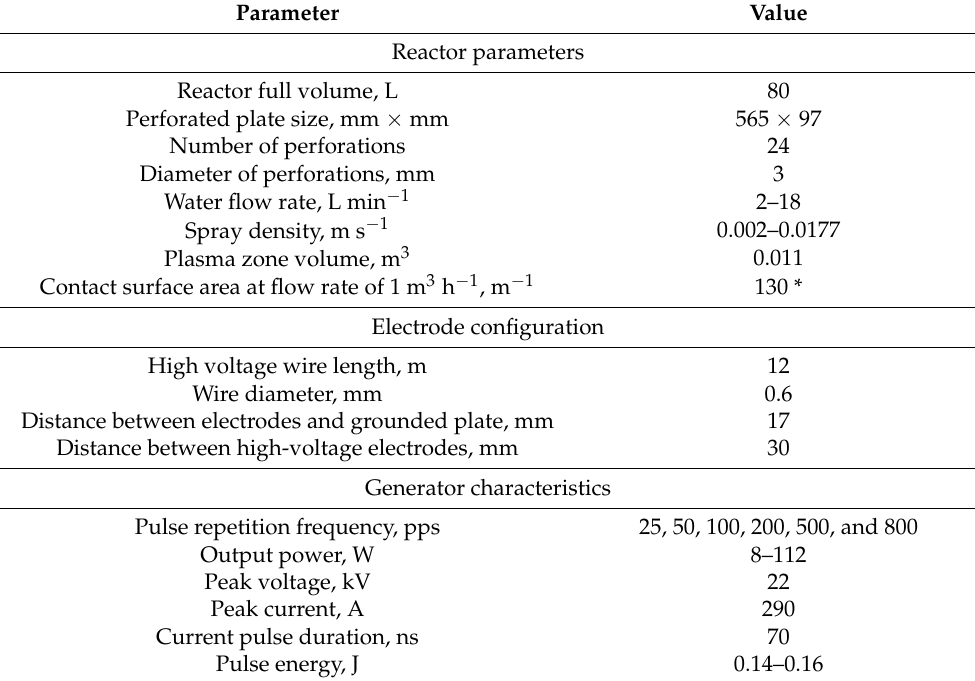
Table 3. Technical parameters of PCD